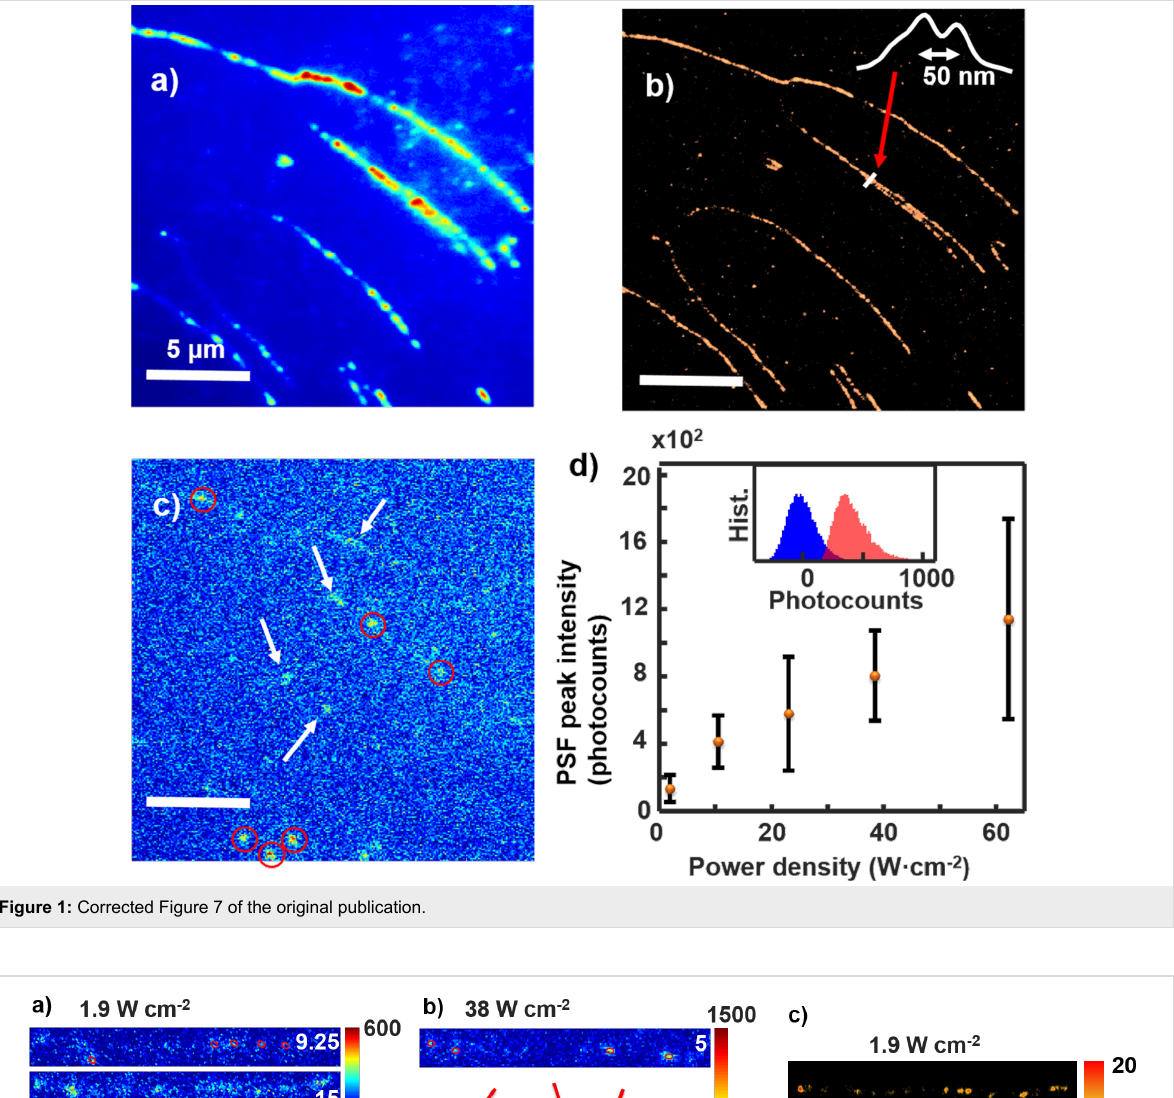
Figure 1: Corrected Figure 7 of the original publication.